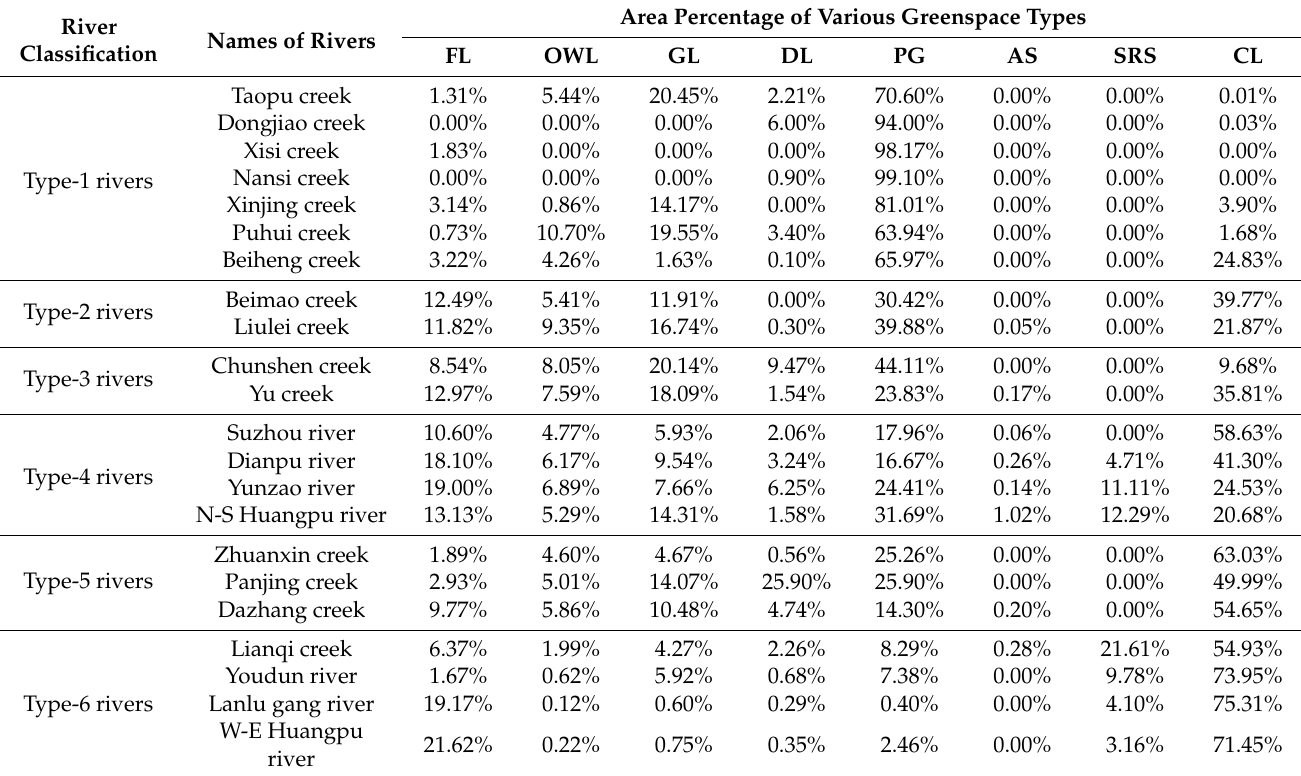
Table 8. Area percentages of various types of riverfront greenspaces at the river reach